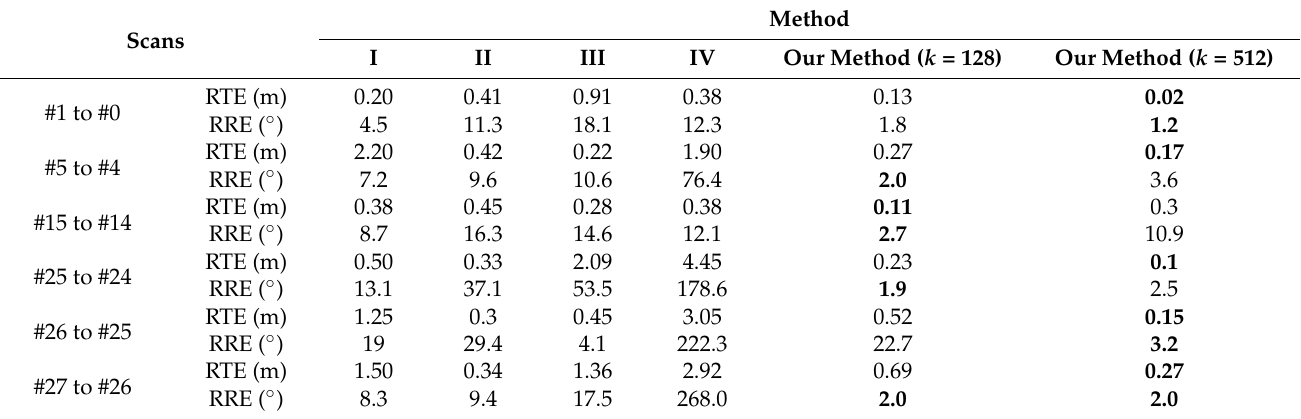
Table 7. The scans where the registrations of most comparison methods fail by using Dataset II under the registration success standard (RTE < 1 m and RRE ≤ 10 ◦